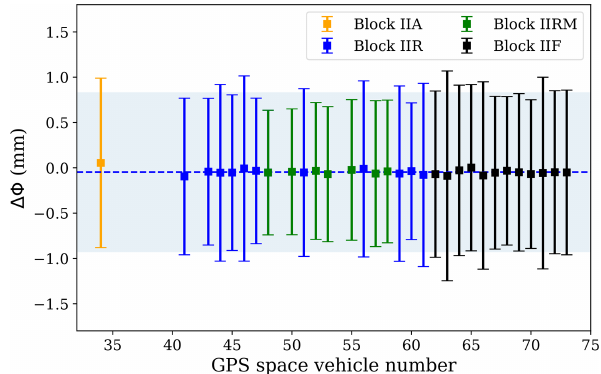
Figure 13. Mean and standard deviation of the (cid:49)(cid:56) measurements for the rain-free cases, at a height of 3km, as a function of the trans- mitter (i.e., the GPS space vehicle number). The blue dashed line and the light blue shadow represent the mean and standard devi- ation of the whole dataset of rain-free cases. Different colors for the error-bar points represent different GPS satellite blocks, as indi- cated in the legend.